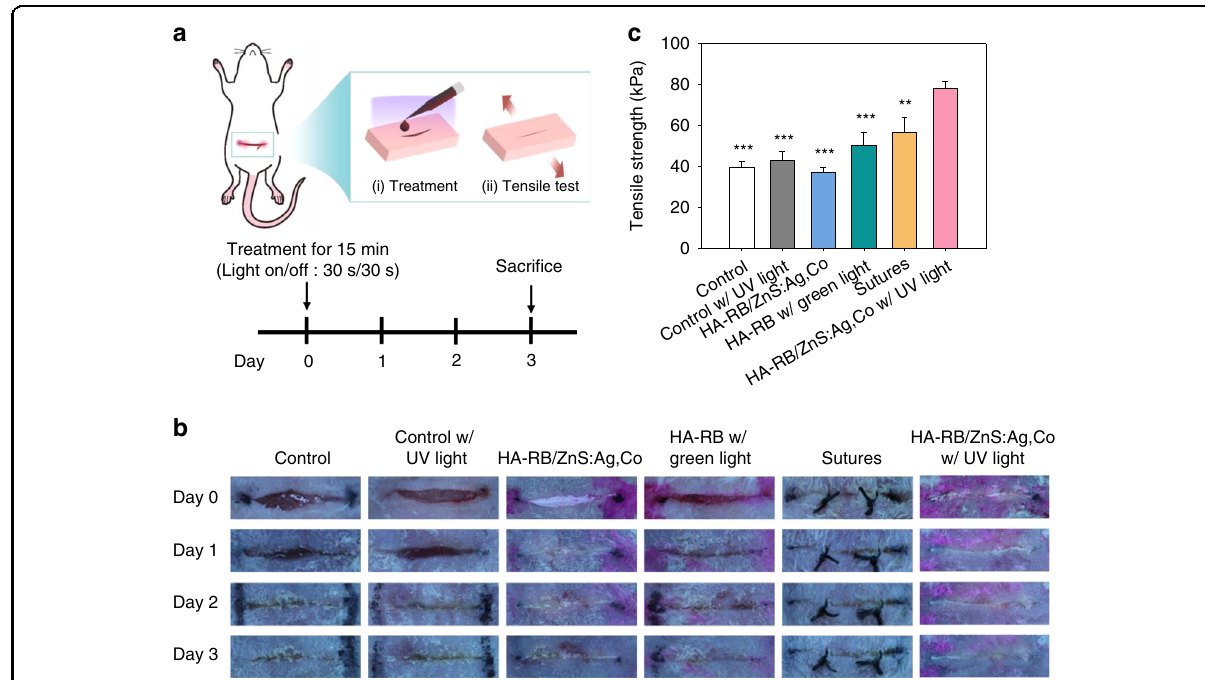
Fig. 6 In vivo wound healing and tensile strength. a Schematic illustration for in vivo PTB procedure. b Photographs of wound regions after treatment with the control (PBS), PBS with UV light, HA-RB/ZnS:Ag,Co mixtures, HA-RB conjugates with green light, sutures, or HA-RB/ZnS:Ag,Co mixtures with UV light irradiation (on/off cycle: 30 s/30 s). c In vivo tensile strength of wound skins treated with each group at day 3 ( n = 4, * P < 0.05, ** P < 0.01, *** P < 0.001 versus HA-RB/ZnS:Ag,Co mixture with UV